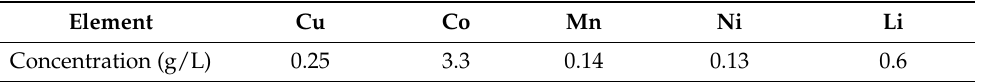
Table 2. Metal content in leach liquor used in the solvent extraction and precipitation